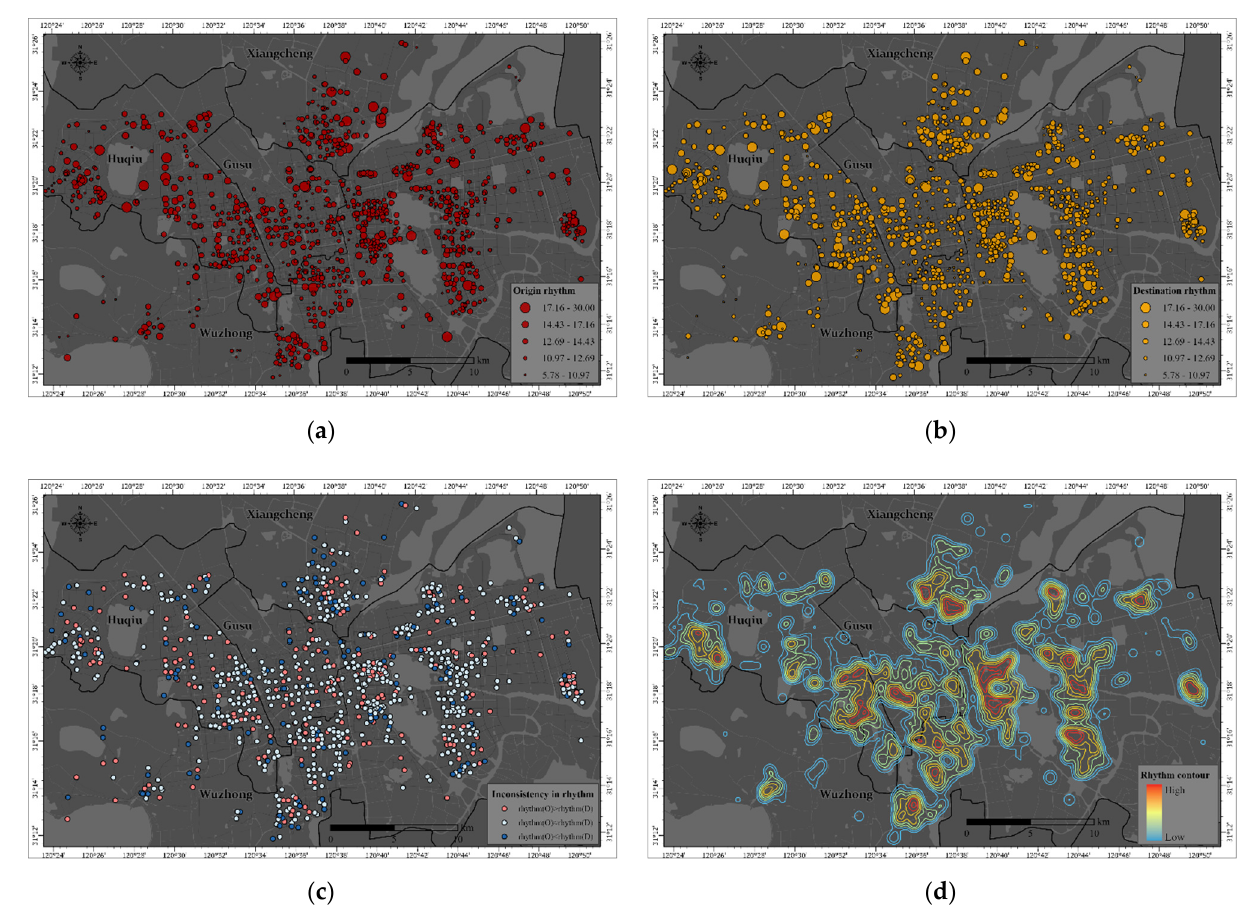
Figure 6. Distribution of cycling rhythm based on stations. ( a ) source rhythm of stations; ( b ) sink rhythm of stations; ( c) inconsistency in cycling rhythm; ( d ) cycling rhythm contour.